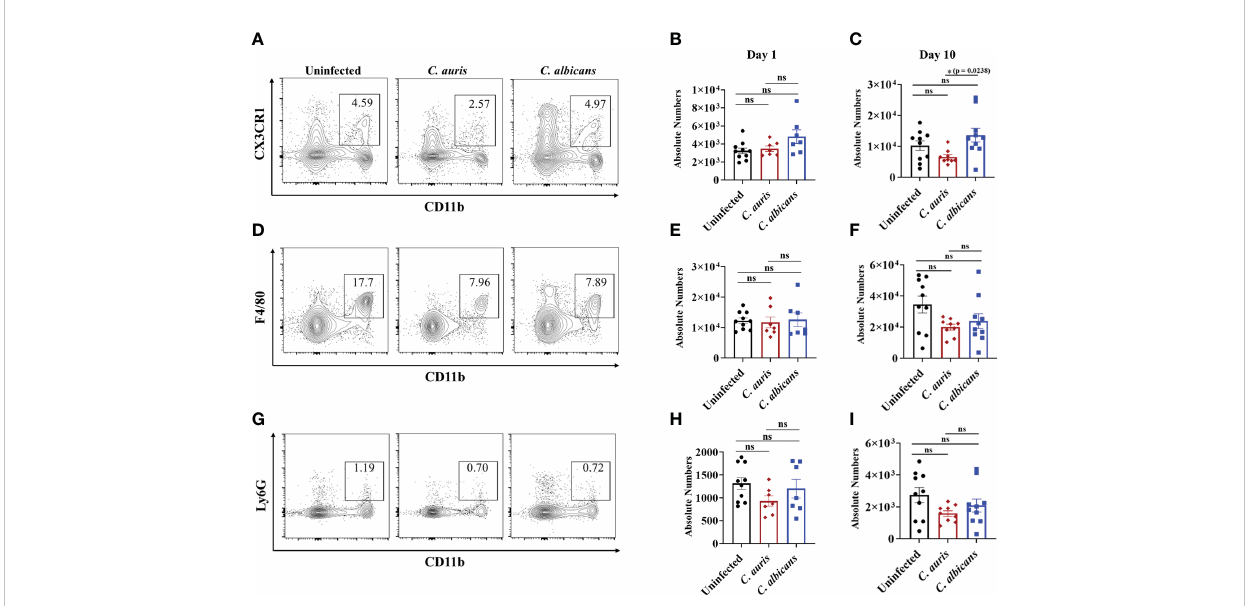
FIGURE 3 Innate immune response in the intestine of C. auris and C. albicans infected mice groups. Mice treated with cefoperazone for 7 days and infected with C. auris 0387 (or) C. albicans SC5314. Antibiotic treatment was continued till the end of experiment and groups of uninfected mice were used as control. (A, D, G) Representative fl ow plots of CD11b+ CX3CR1+ macrophages, CD11b+ F4/80+ macrophages and CD11b+ Ly6G+ neutrophils from the large intestine of uninfected, C. auris (or) C. albicans infected mice after 10-12 days post infection was shown here. (B, E, H) Absolute number of CD11b+ CX3CR1+ macrophages, CD11b+ F4/80+ macrophages and CD11b+ Ly6G+ neutrophils from the large intestine of uninfected, C. auris (or) C. albicans infected mice after one day post infection was shown here. (C, F, I) Absolute number of CD11b+ CX3CR1+ macrophages, CD11b+ F4/80+ macrophages and CD11b+ Ly6G+ neutrophils from the large intestine of uninfected, C. auris (or) C. albicans infected mice after 10- 12 days post infection was shown here. Each group had 7-10 mice and the data represents mean ± SEM. Statistical signi fi cance of differences between the groups was calculated using the Kruskal-Wallis test followed by Dunn ’ s multiple comparison test with ns – nonsigni fi cant, * p ≤